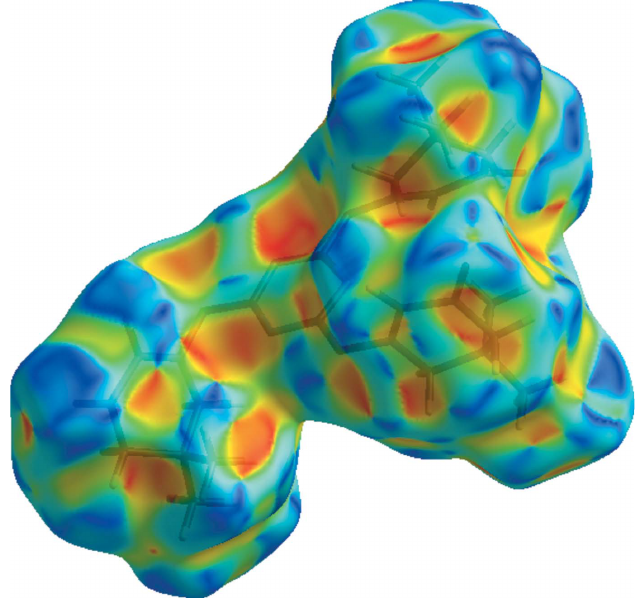
Figure 5 View of the three-dimensional Hirshfeld surface of the title complex plotted over